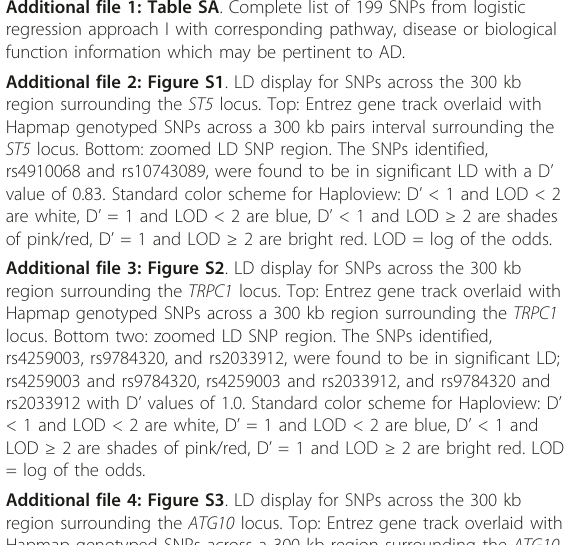
Additional file 5: Figure S4 . LD display for SNPs across the 300 kb region surrounding the ANO3 locus. Top: Entrez gene track overlaid with Hapmap genotyped SNPs across a 300 kb region surrounding the ANO3 locus. Bottom two: zoomed LD SNP region. The SNPs identified,